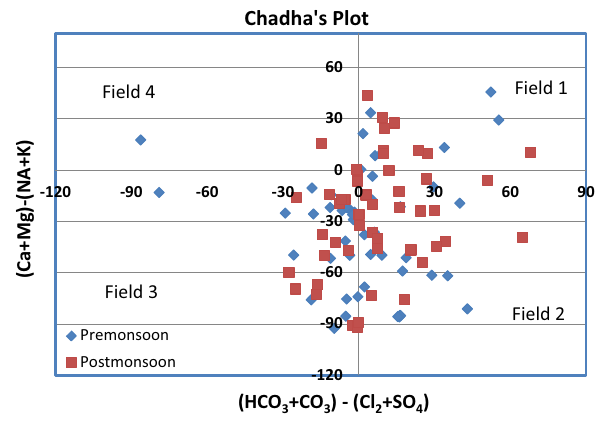
Fig. 4 Groundwater samples plotted in Chadha’s